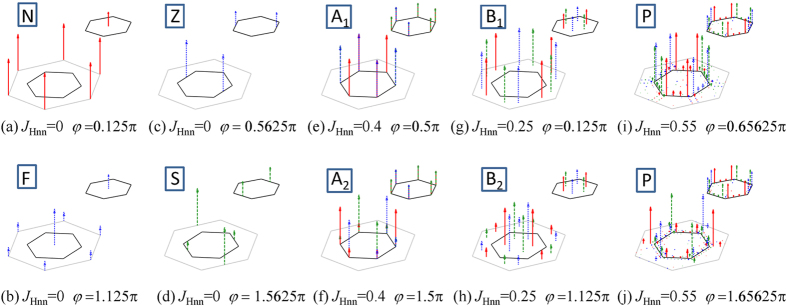
The typical spin structure factors for (a) N, (b) F, (c) Z, (d) S, (e) A1, (f) A2, (g) B1, (h) B2, (i,j) P phases. The main figure presents the spin structure factor on the honeycomb lattice (Shγ(k)) where the gray large hexagon represents the extended Brillouin zone and the inner black hexagon indicates the first Brillouin zone. The small inset in the top right corner of each figure shows the spin structure factor on one triangular sublattice (Stγ(k)). The solid (red), dashed (green) and dotted (blue) lines with arrows denote the signals from Sx, Sy and Sz respectively.